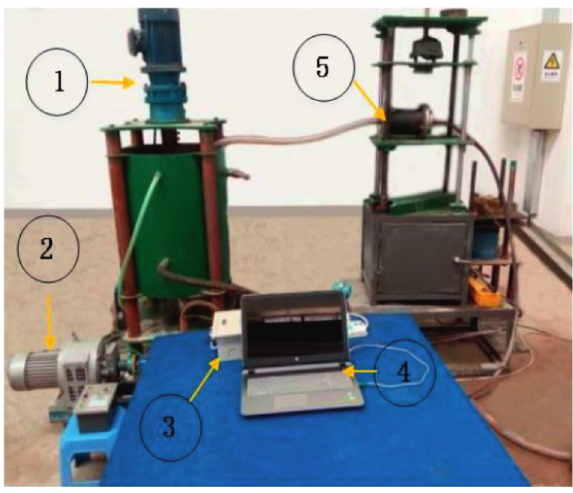
Figure 3: Water injection system to measure hydraulic extrusion: 1, mixing system; 2, sewage pump; 3, acquisition card; 4, computer; 5, seepage